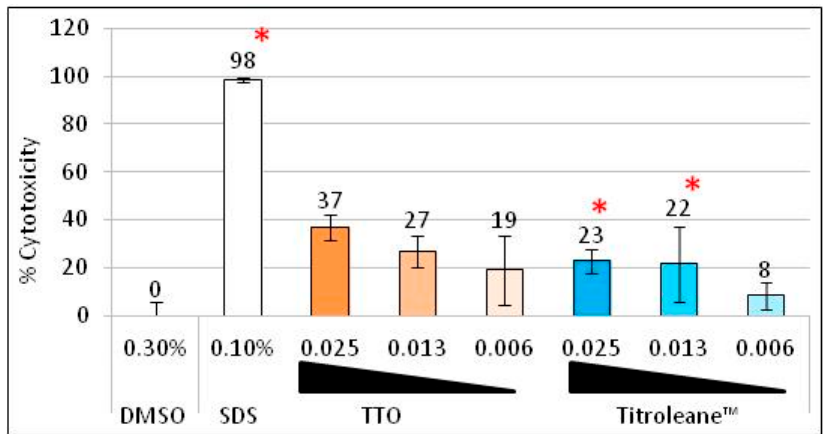
Figure 1. Cytotoxicity of TTO versus Titroleane ™ . Cytotoxicity percent of TTO and Titroleane ™ on human foreskin fibroblast cell lines after 24 h of contact. Extracts are prepared in 0.3% DMSO. Concentrations ranged from 0.025% to 0.006% ( v / v ). Experiment was performed three times in triplicates on different days. * = p < 0.05.